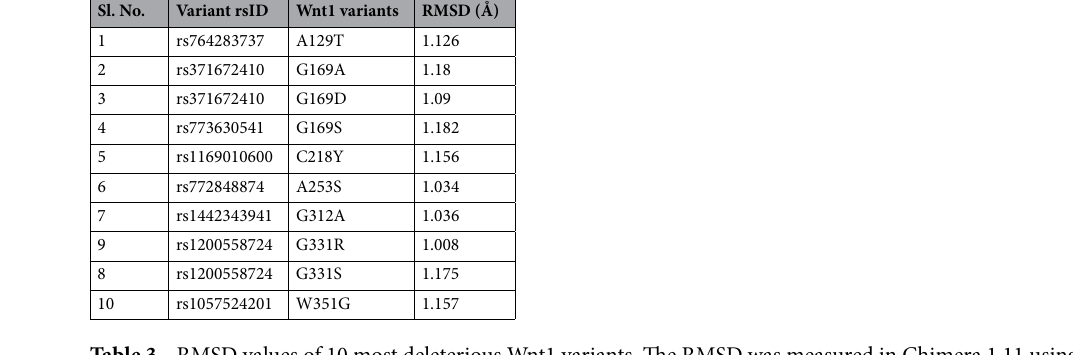
Table 3. RMSD values of 10 most deleterious Wnt1 variants. The RMSD was measured in Chimera 1.11 using wild type Wnt1 as reference.